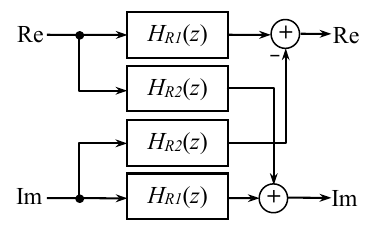
Fig. 1. Block diagram of a complex filter [3].